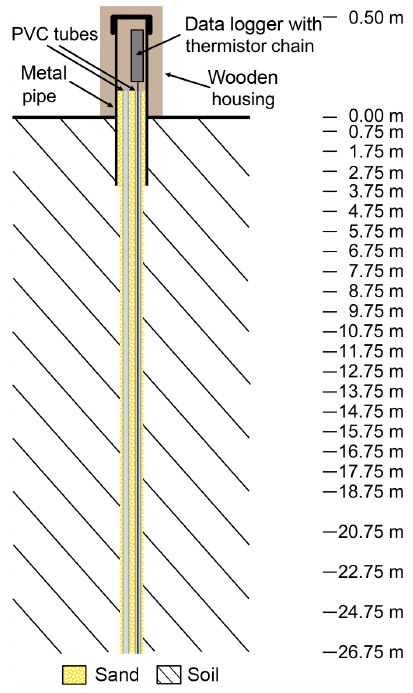
Figure E2. Thermistor setup showing their depths within the bore- hole, as installed in 2006. The metal pipe extends 0.5m above ground surface. Note the differences in scale above and below the ground